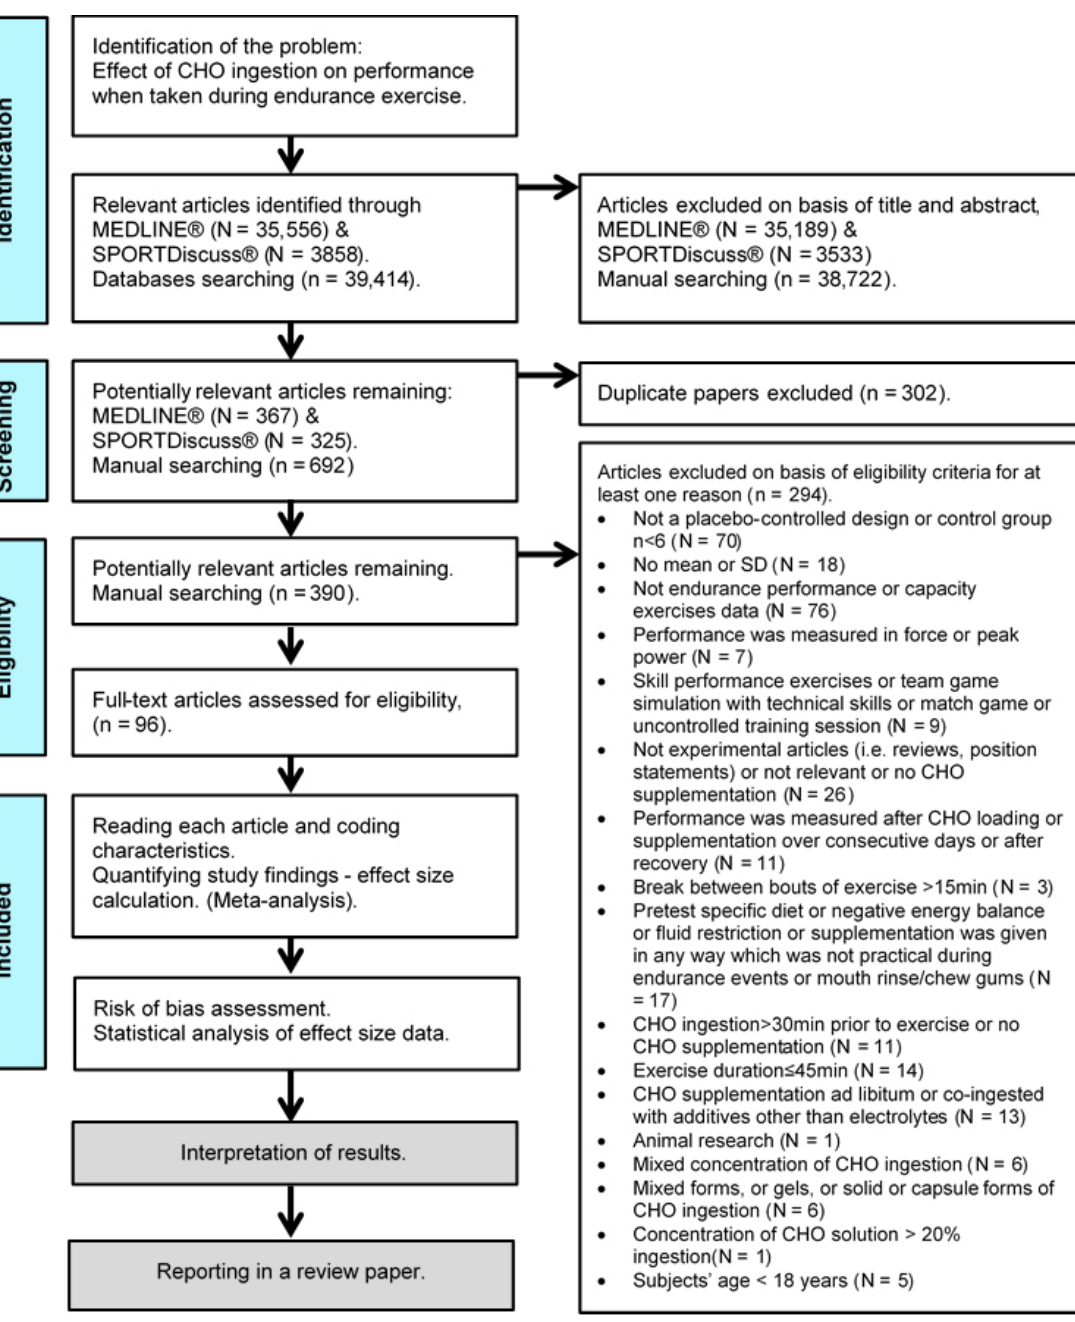
Figure 1. Prisma flowchart of the study selection process [16].